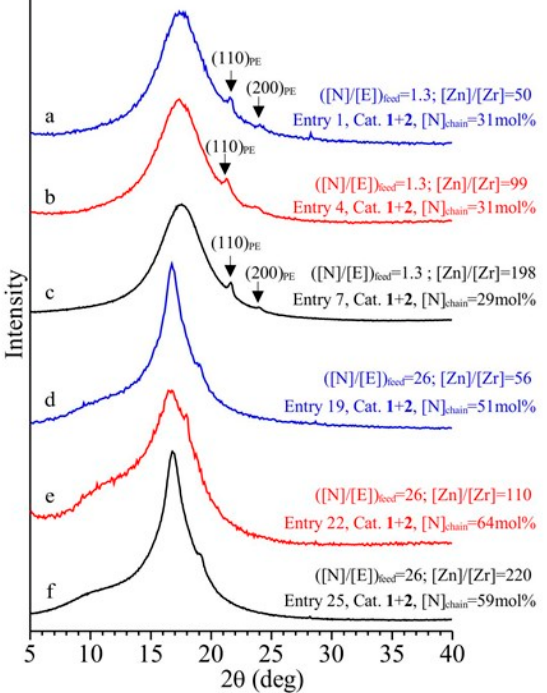
Figure 6. X-ray powder diffraction profiles of melt crystallized poly(ethylene- co -norbornene) samples obtained with catalysts 1 + 2 at [N]/[E] feed ratio of 1.3, 4.8 and 26.0, using the indicated values of the [Zn]/[Zr] ratio during polymerization.